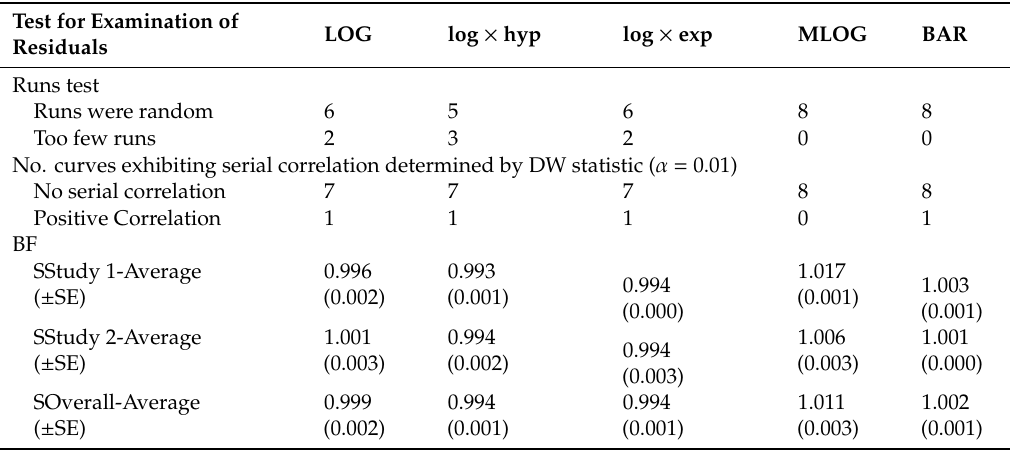
Table 4. Examination of residuals using the runs test, Durbin–Watson (DW) and averaged bias factor (BF) statistics obtained when fitting models to growth data from Study 1 and